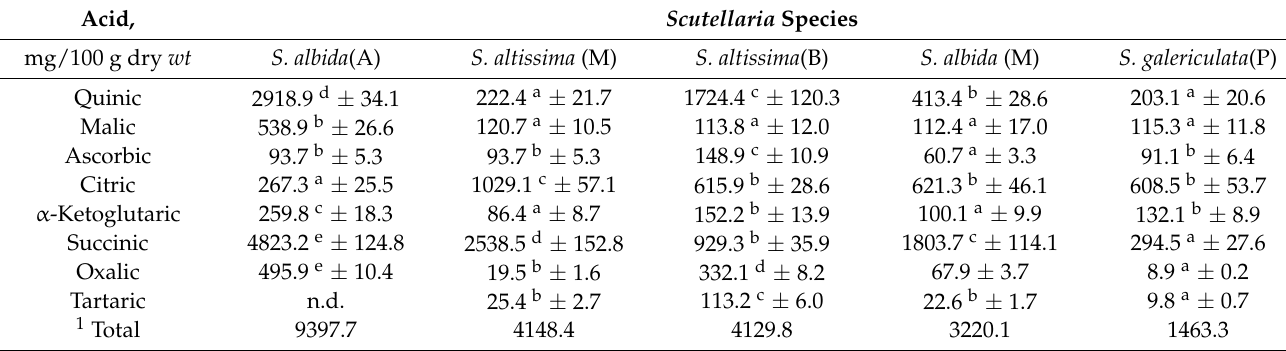
Table 3. Content of Organic Acids in Scutellaria